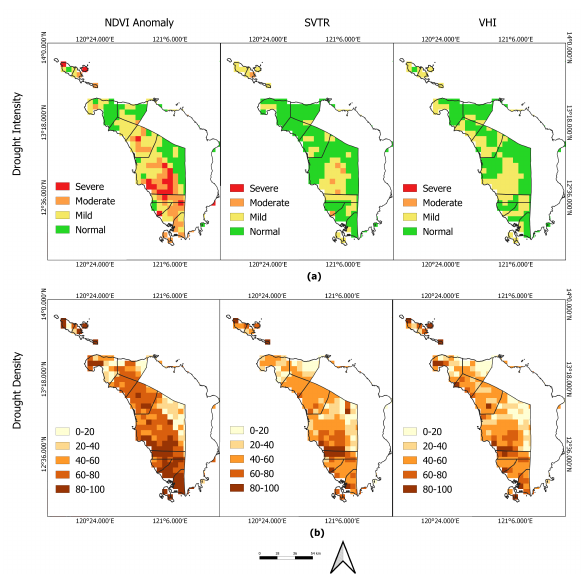
Figure 7. Drought intensity and density map of SVTR, VHI, NDVI